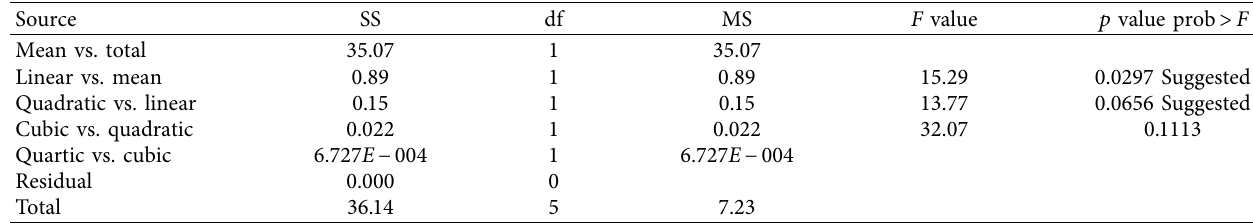
Table 14: Sequential model sum of squares (type I) for flexural strength